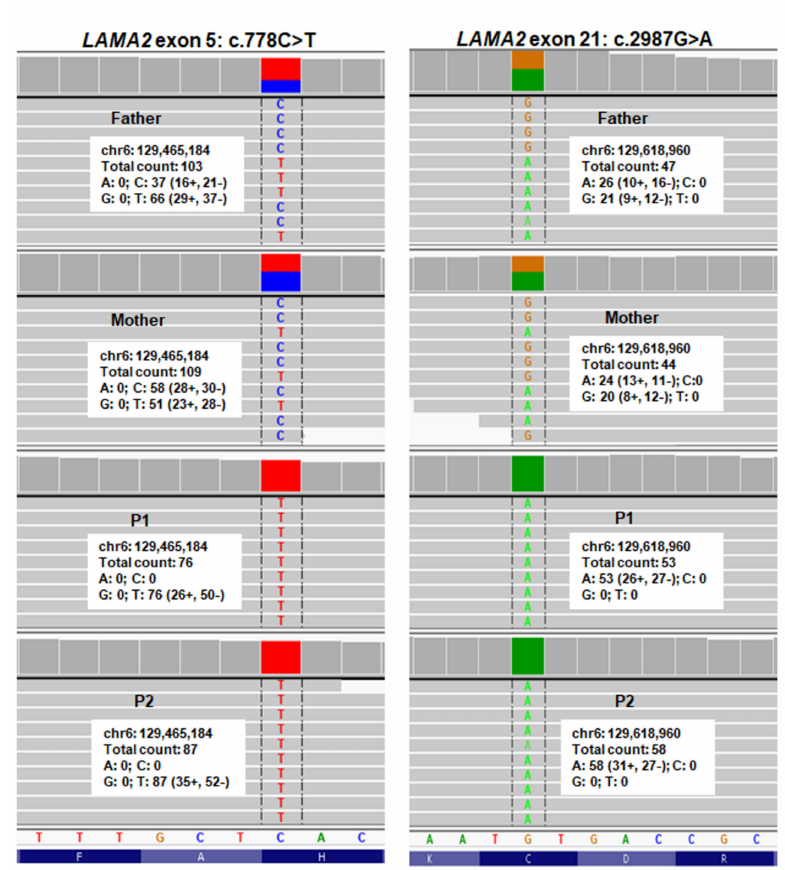
Figure 1. Whole genome sequencing paired-end reads of the family are loaded in the Integrative Genomics Viewer genome